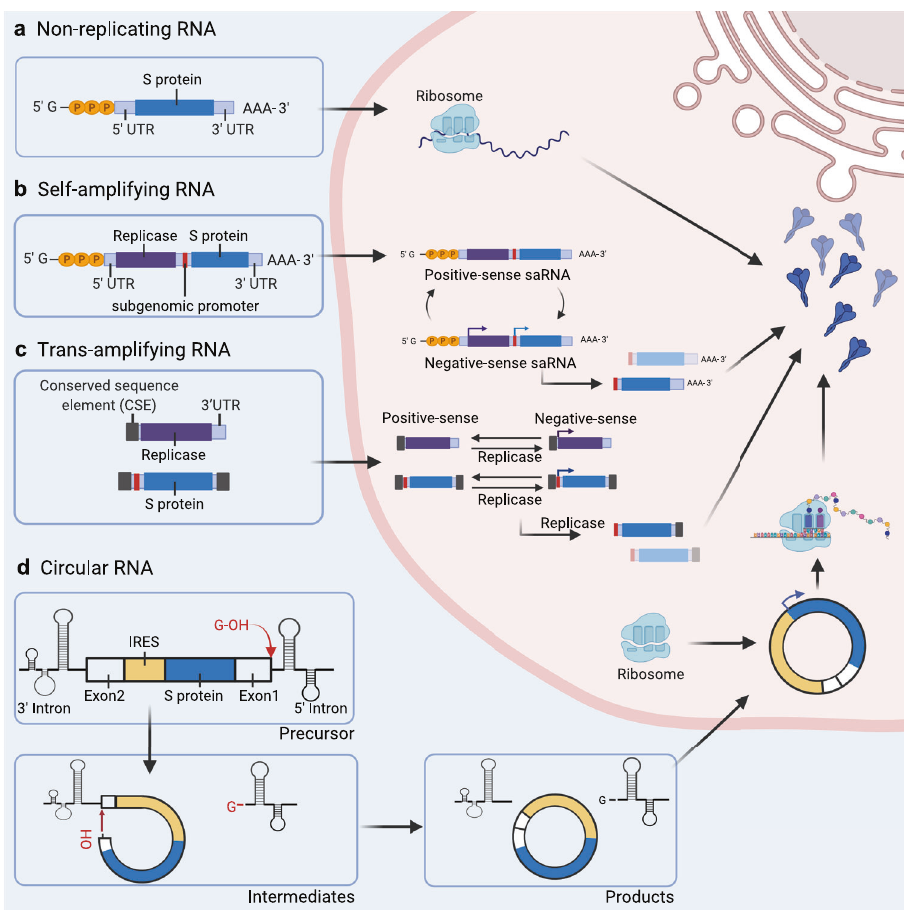
Fig. 3 Antigen expression in different types of mRNA vaccines. A The vaccine immunogen is encoded by a non-replicating RNA fl anked by 5 ′ and 3 ′ UTRs (S protein). B Self-amplifying RNA (saRNA) encodes four nonstructural proteins (nsp 1 – 4) and a subgenomic promoter derived from the alphavirus genome. saRNA encodes a replicase and ampli fi es vaccine-encoding transcripts. C Trans-amplifying RNA (taRNA) uses two transcripts to enable self-ampli fi cation of replicase and the immunogen. D Circular RNA (circRNA) is circularized by the autocatalytic Group I ribozyme. 223 The exon 2 is ligated upstream to exon 1, and a coding region is inserted between the exon-exon junction. During splicing, the 3 ′ -OH of a guanosine nucleotide engages in a transesteri fi cation reaction at the 5 ′ splice site. The 5 ′ intron is excised, and the 3 ′ -OH at the end of the intermediate engages in a second transesteri fi cation reaction at the 3 ′ splice site, resulting in the circularization of the immunogen mRNA. Upon entering the cell, the internal ribosome entry site (IRES) of circRNA initiates protein translation. The fi gures are created with